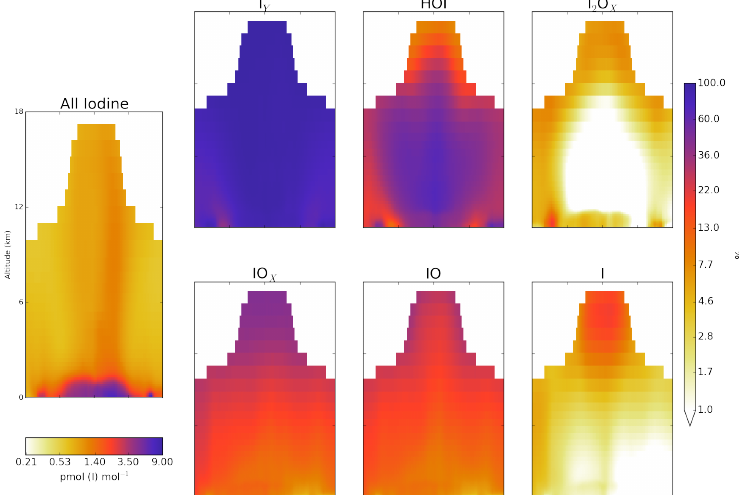
Figure 9. Zonal breakdown of global annual mean iodine speciation by family in the “Br + I” simulation. First panel shows total gas phase iodine concentration and the following panels show percentage of different compounds to this. Total gas phase iodine (“All Iodine”) =